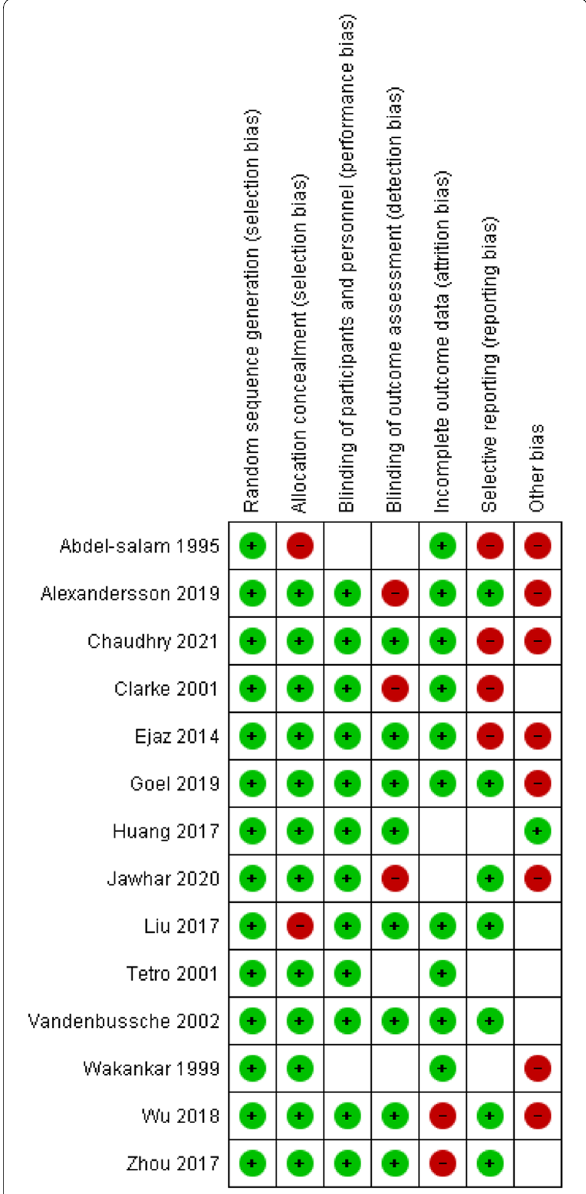
Fig. 3 Methodological assessment of the included